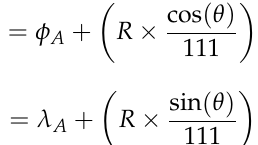
Figure 9. Two consecutive detection results using the ASI algorithm; the green arrows are radar